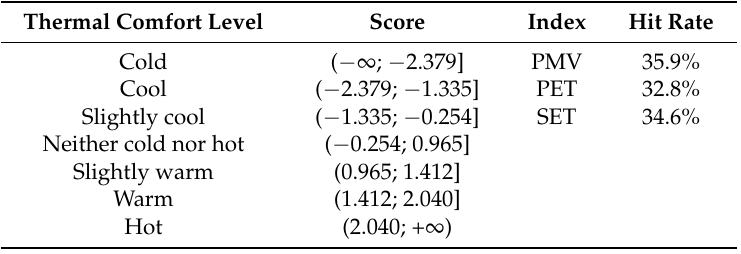
Table 1. Classes corresponding to score intervals following the calculation of optimized cutoff points and hit rates of the analyzed indexes. PMV, Predicted Mean Vote; PET, Physiological Equivalent Temperature; SET, New Standard Effective Temperature (SET).